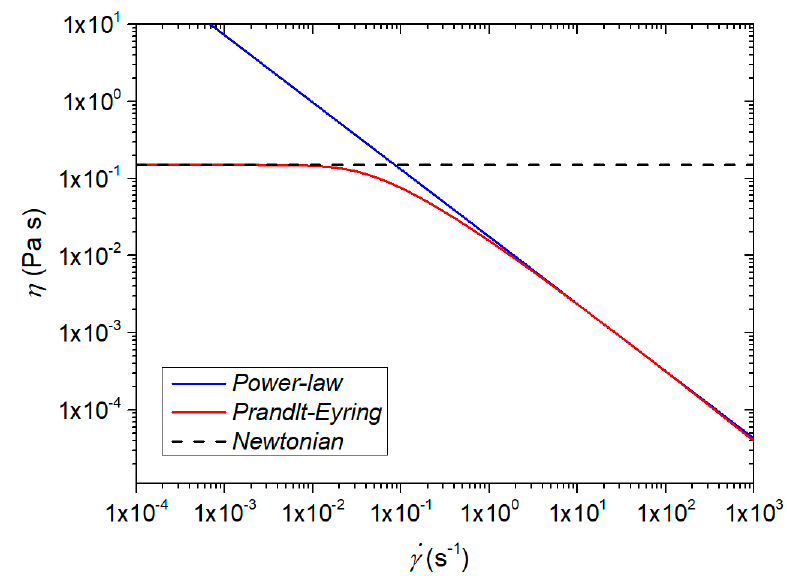
Figure 7. Plot of viscosity vs. strain rate: strain-rate viscosity form fit a Prandtl–Eyring rheology ( A = 0.003465 Pa and B = 0.0231 s − 1 ) of a power-law model (˜ µ = 0.0175 Pa × s n and n =